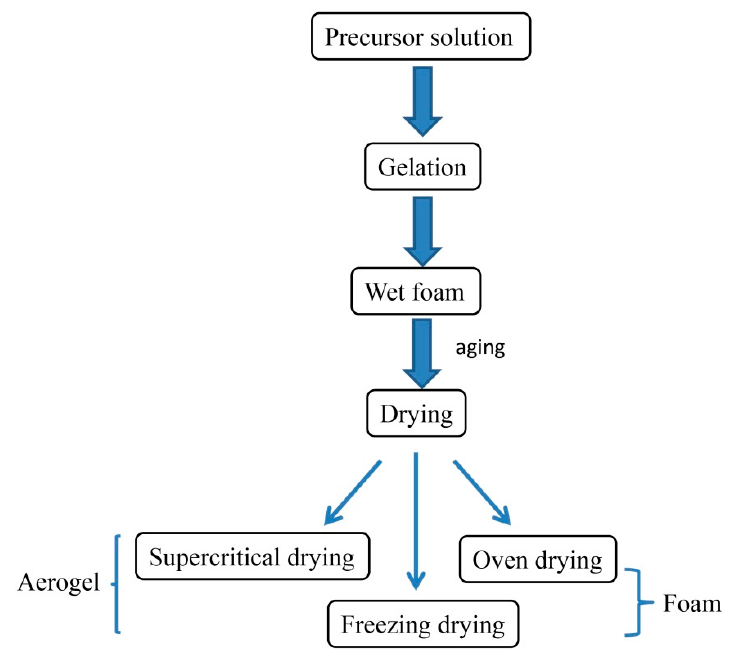
Figure 6. A flow chart on preparation of porous solid materials. Table 2. A comparison of drying approaches for various solid foam.